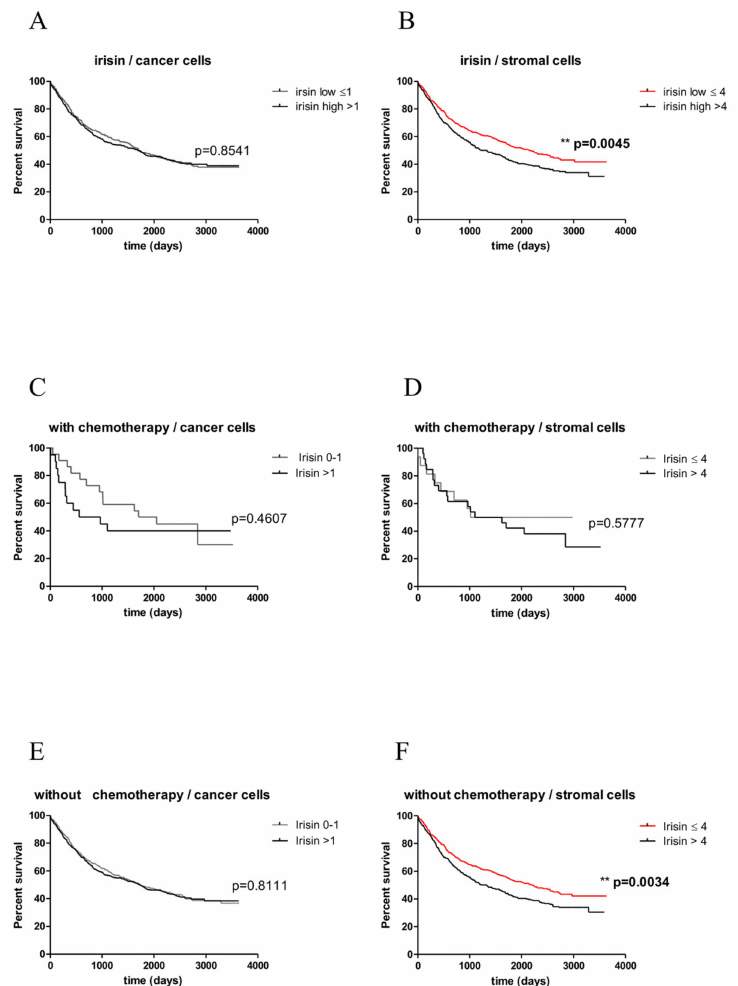
Figure 7. Kaplan-Meier survival curves presenting the prognostic impact of irisin expression levels detected by immunohistochemistry (IHC) in cancer ( A , C , E ) and stromal cells ( B , D , F ) on overall survival (OS) of patients with non-small cell lung cancer (NSCLC). Patients were grouped according to the median value of the immunohistochemical expression of irisin in cancer and stromal cells of NSCLCs. The prognostic impact of irisin expression levels was studied in the whole patient group ( A , B ) and according to whether they received ( C , E ) or did not receive ( D , F ) preoperative